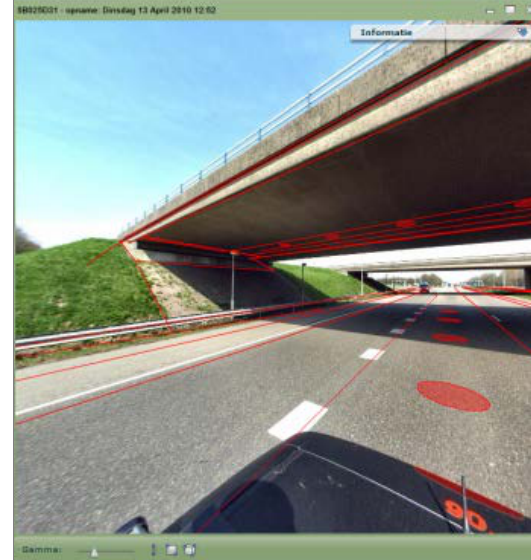
Figure 11. 3D data overlaid on plain Cyclorama